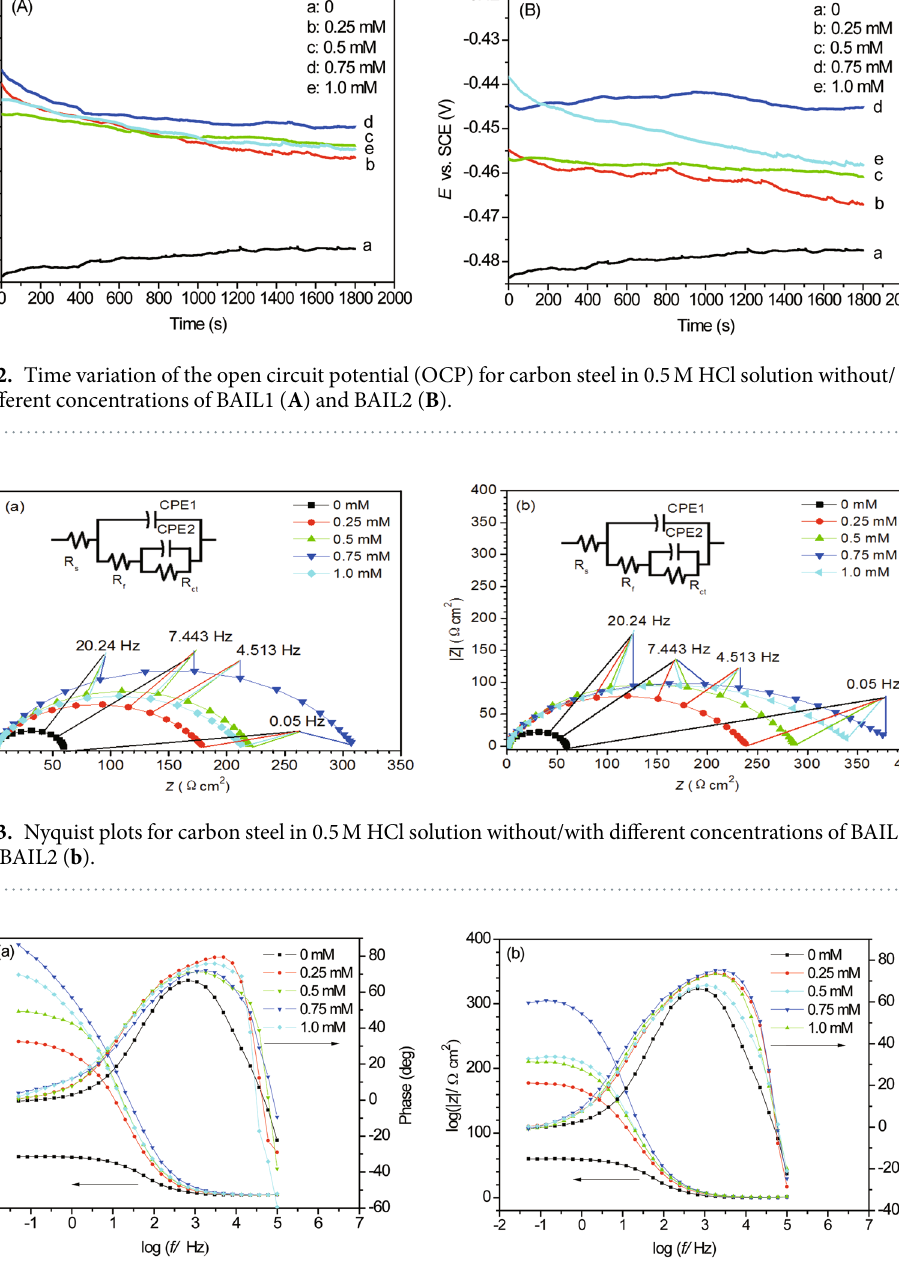
Figure 4. Bode plots for carbon steel in 0.5 M HCl solution without/with different concentrations of BAIL1 ( a ) and BAIL2 ( b